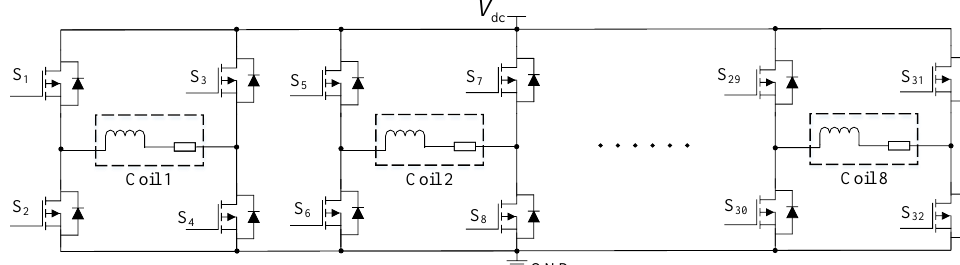
Figure 4. Full-bridge circuit of the SPA for a four DOF AMB.